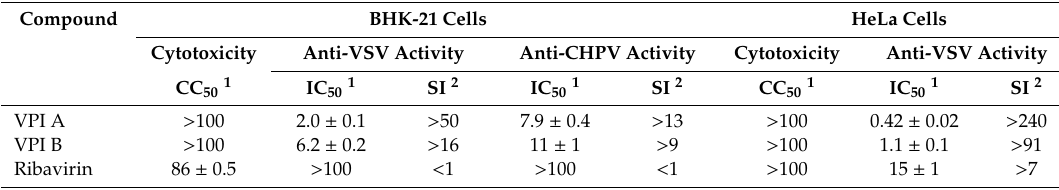
Table 2. Anti-vesiculoviral activities of VPI A, VPI B, and ribavirin.